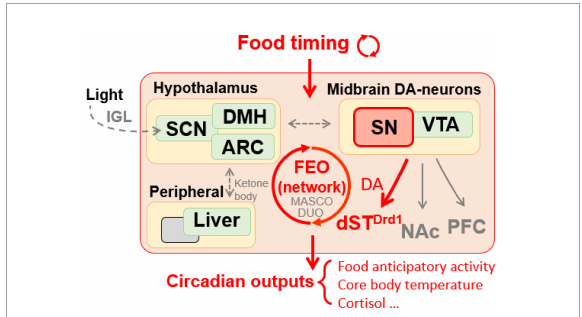
FIGURE1 Food timing, particularly when restricted temporally, is a potent zeitgeber entraining an oscillatory system in the brain, relaying rhythmic behavior outputs. DA signaling is required in SN neurons projecting to the dorsal striatum but not the NAc or PFC to mediate food anticipatory activity. Peripheral oscillators, like the liver, may contribute to food entrainment via ketone bodies secretion to unknown brain target(s). Hypothalamic areas are also suggested to be involved in food entrainment regulation. Ambient light pathway via IGL influences the proper development of SCN structure which is necessary for proper food entrainment. SN, substantia nigra; VTA, ventral tegmental area; ARC, arcuate nucleus; DMH, dorsomedial hypothalamus; SCN, suprachiasmatic nucleus; IGL, intergeniculate leaflet; Drd1, D1 dopamine receptor; dST, dorsal striatum; NAc,